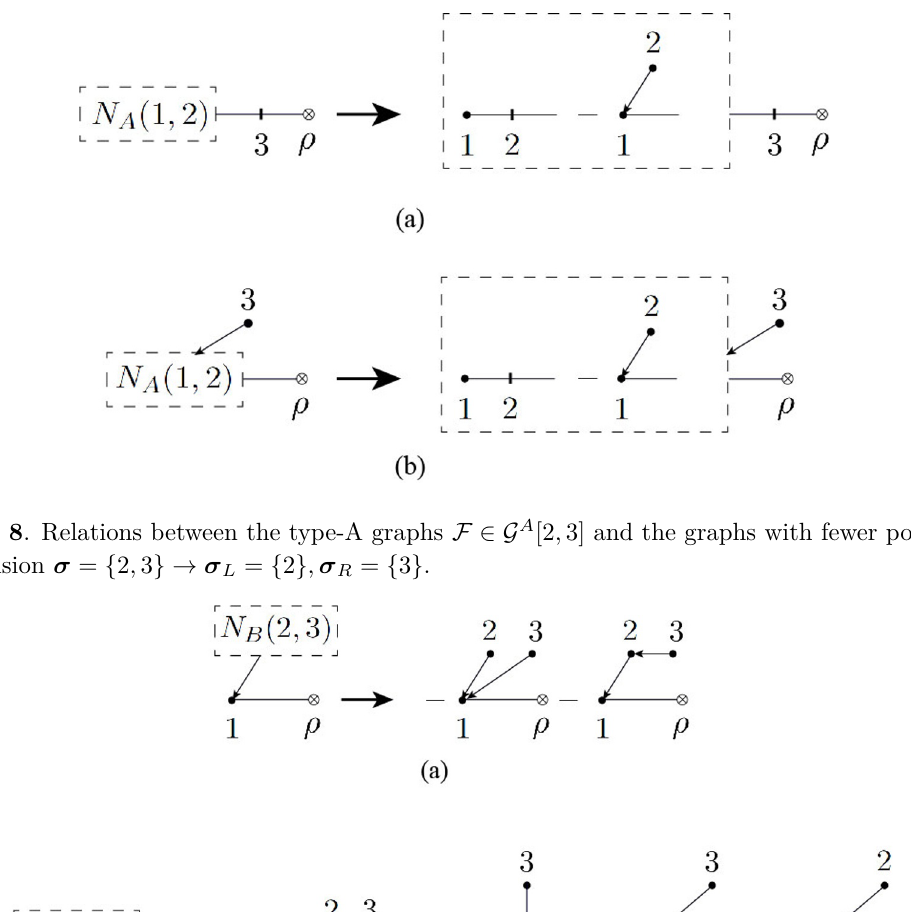
Figure 9 . Relations between the type-A graphs F ∈ G A [2 , 3] and the graphs with fewer points for the division σ = { 2 , 3 } → σ